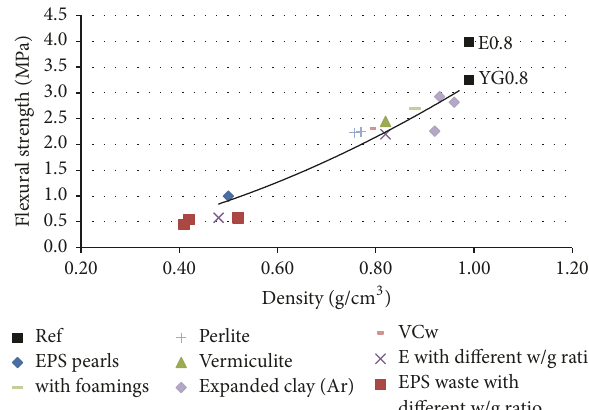
Figure 4: Comparison of proposed model with the results obtained by other authors. Flexural strength.